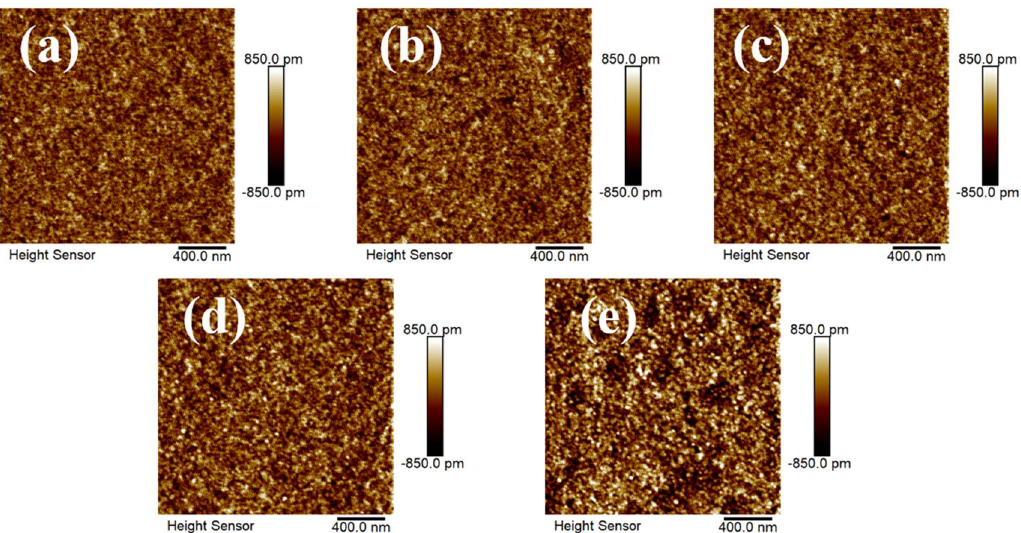
Figure 2. AFM images of In-Yb-O thin films with different Yb ratios of: ( a ) 0%, ( b ) 2%, ( c ) 5%, ( d ) 10%, and ( e ) 20%.